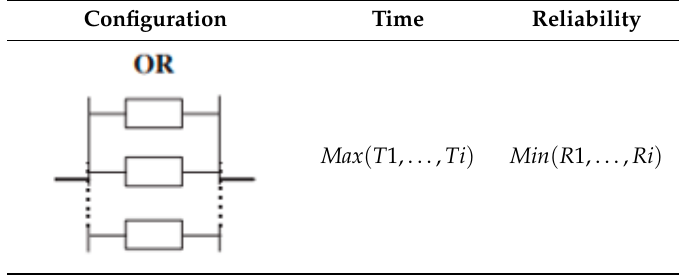
Table 1. Performance aggregation computation.